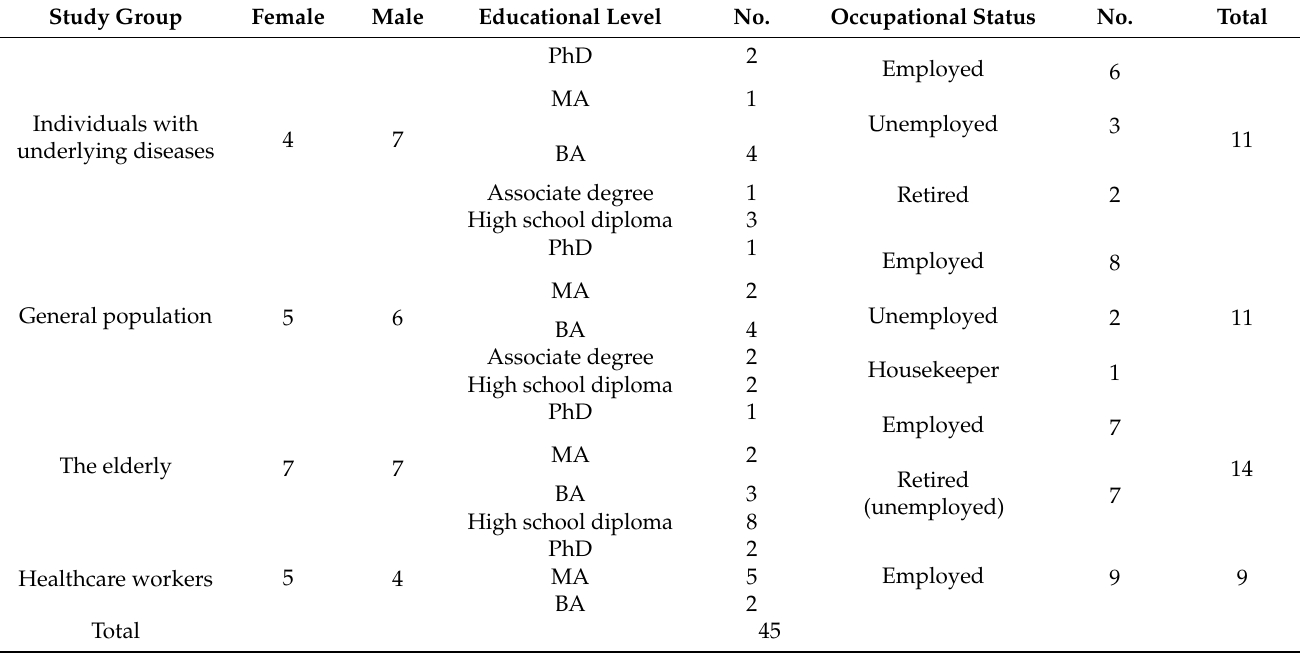
Table 1. The Demographic Characteristics of the Participants in the Qualitative